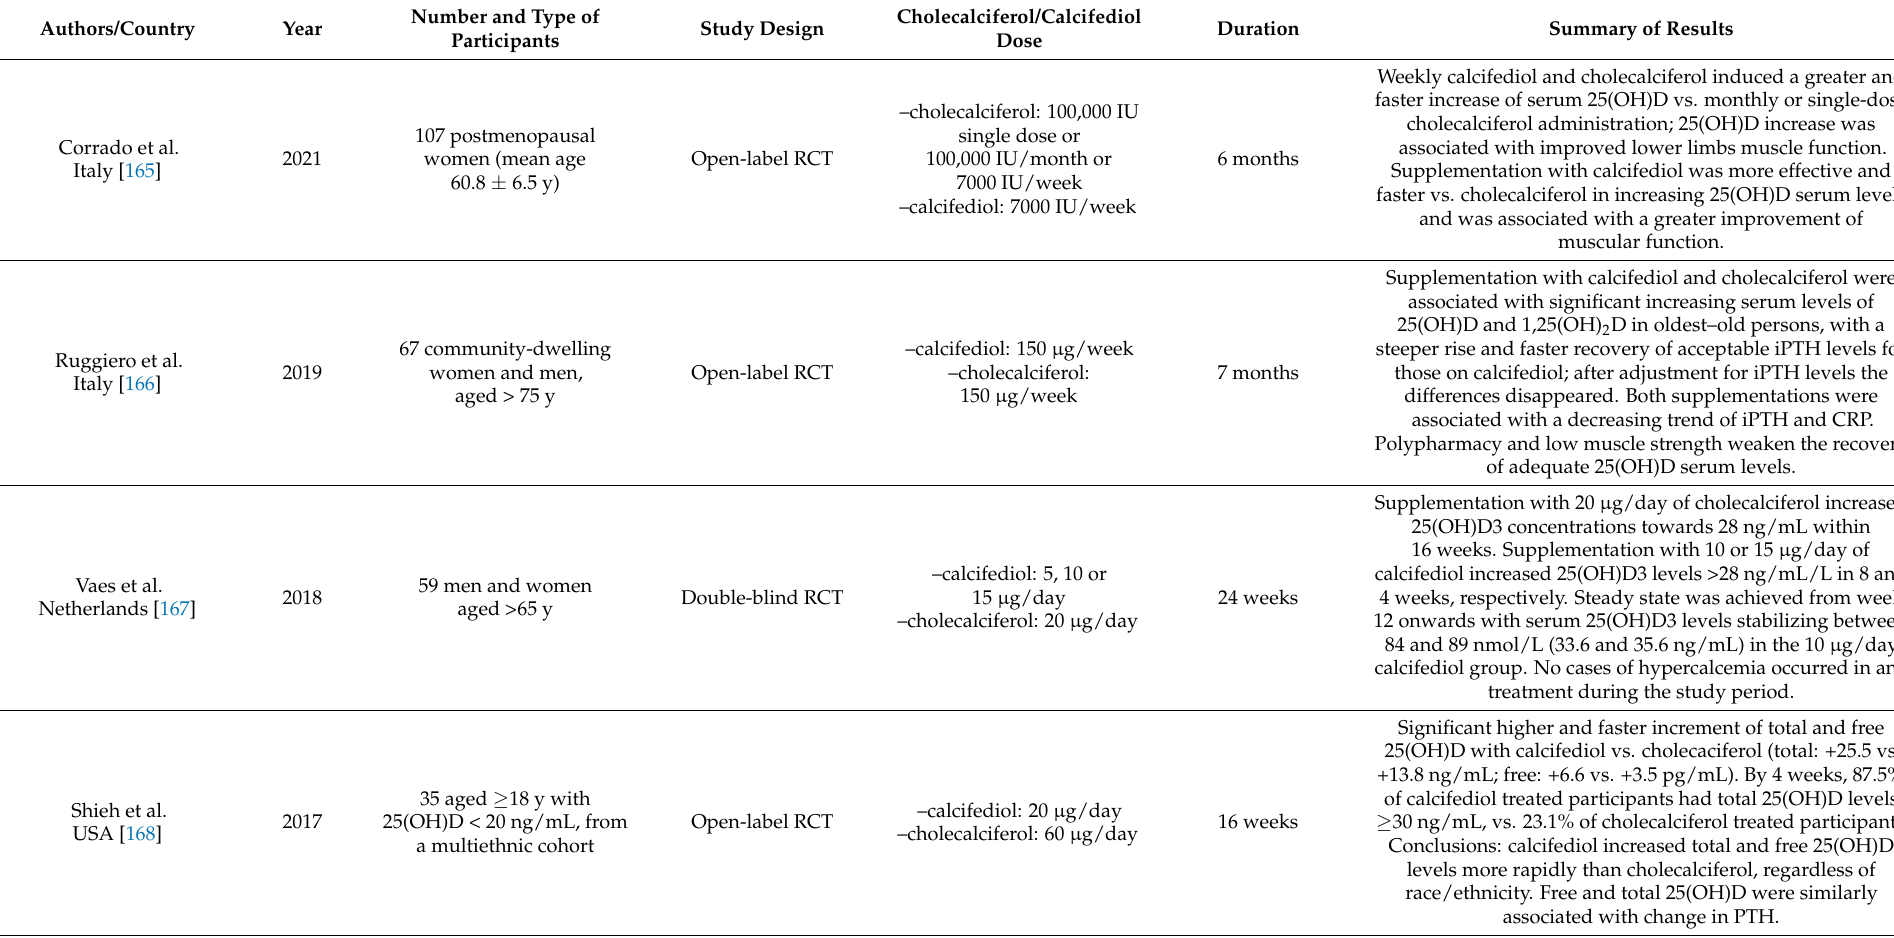
Table 7. Summary of results from studies comparing supplementation with cholecalciferol vs.